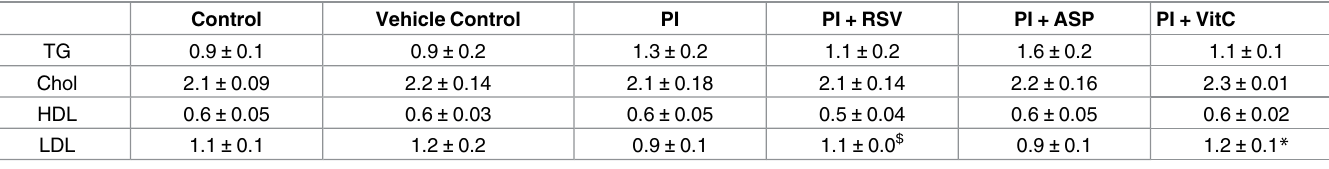
Table 2. Blood Metabolite Levels following 4 Months of Treatment.